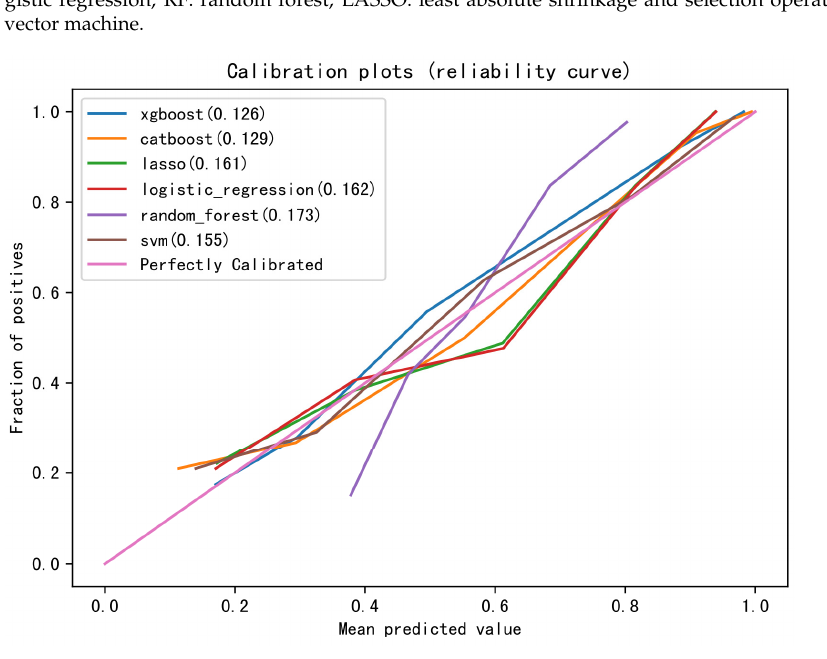
Figure 4. Calibration curves of the six ML models.